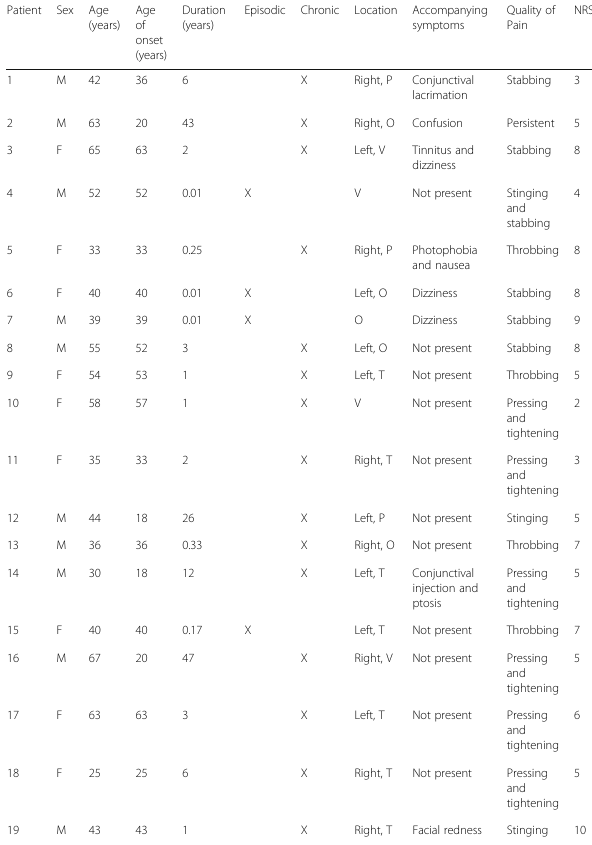
Table 1 (abstract O53). Clinical profiles of nummular headache